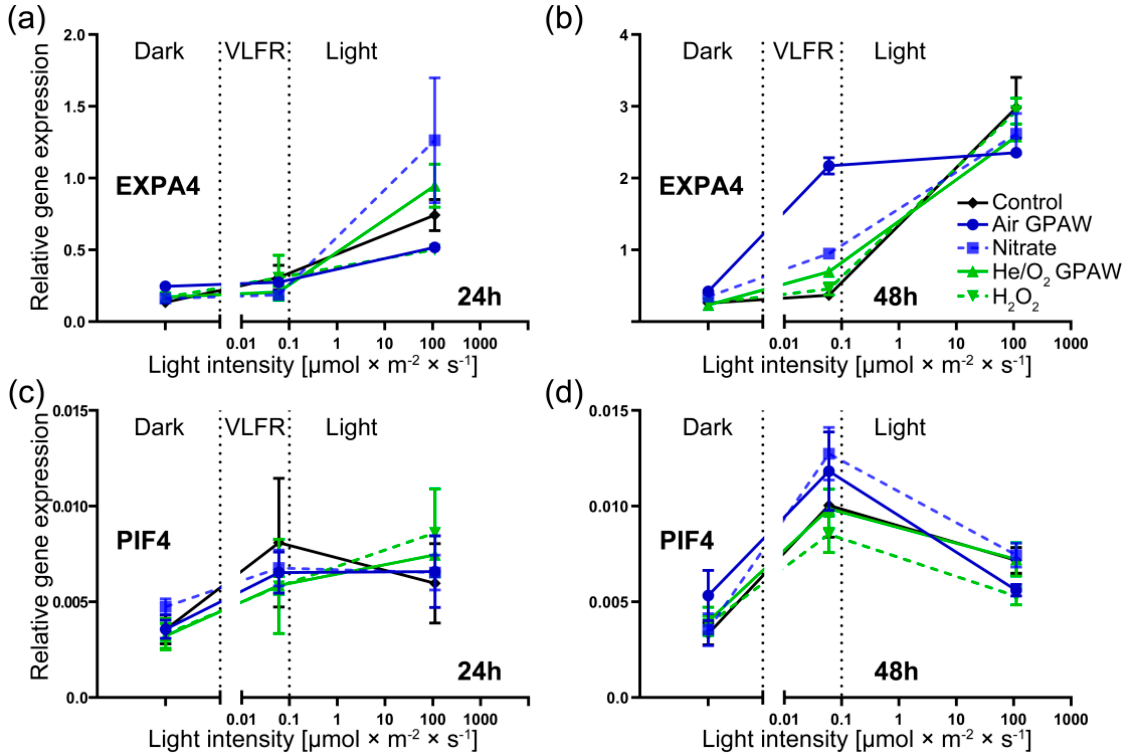
Figure 6. Relative gene expression of freshly harvested Nicotiana tabacum seeds displaying photo- dependent dormancy and germination responses in three different continuous light conditions (darkness (0 µ mol m − 2 s − 1 ), VLFR-intensity white light (0.05 µ mol m − 2 s − 1 ) and LFR-intensity white light (111 µ mol m − 2 s − 1 )) at 2 time points (24 and 48 h). Seeds were incubated at 20 °C with 5 treatments: Air GPAW, He/O 2 GPAW, Nitrate (5 mM KNO 3 − ), H 2 O 2 (300 µM), and water. ( a , b ) Gene expression of EXPA4 at 24 and 48 h, respectively. ( c , d ) Gene expression of PIF4 at 24 and 48 h, respectively.